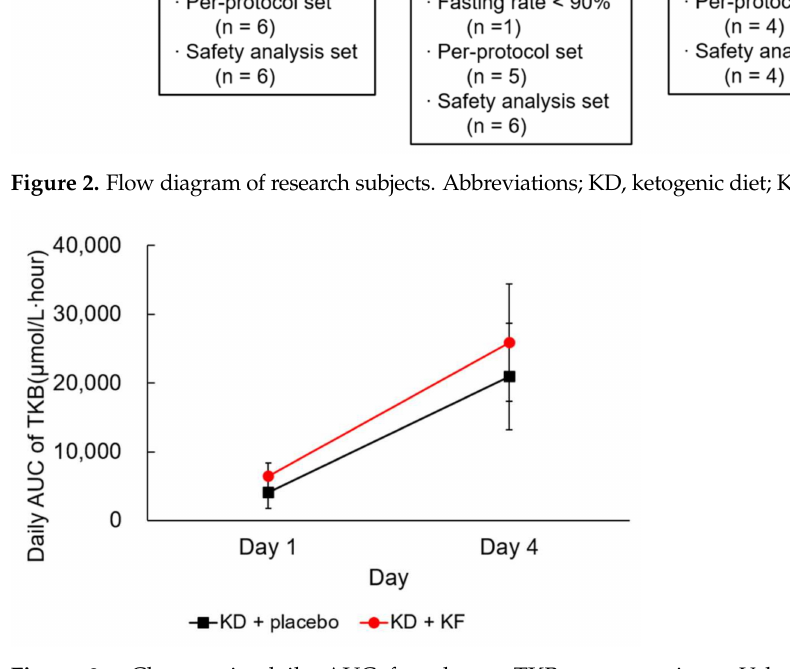
Figure 3. Changes in daily AUC for plasma TKB concentration. Values are presented as mean ± standard deviations. Abbreviations; AUC, area under the curve; TKB, total ketone body. Table 2. Comparison of daily AUC of plasma TKB concentration between Day 1 and Day